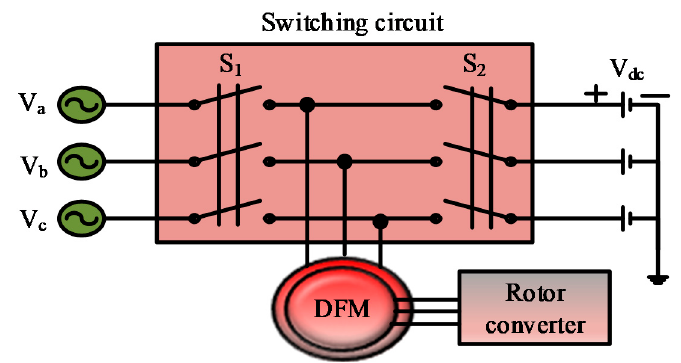
Figure 1. Schematic of ideal transfer switch in double-fed machine (DFM) [10].